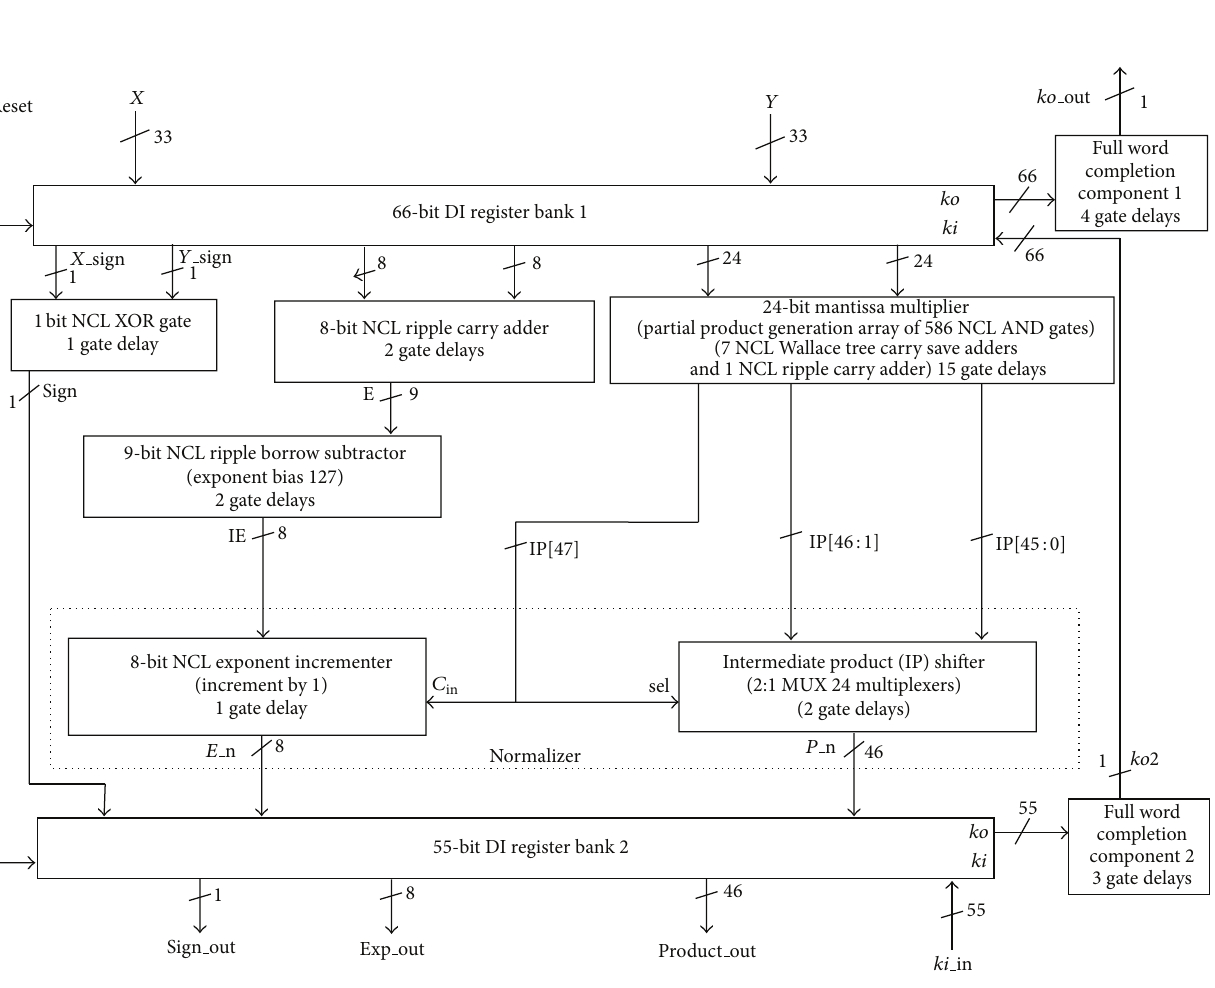
Figure 11: NCL floating point multiplier